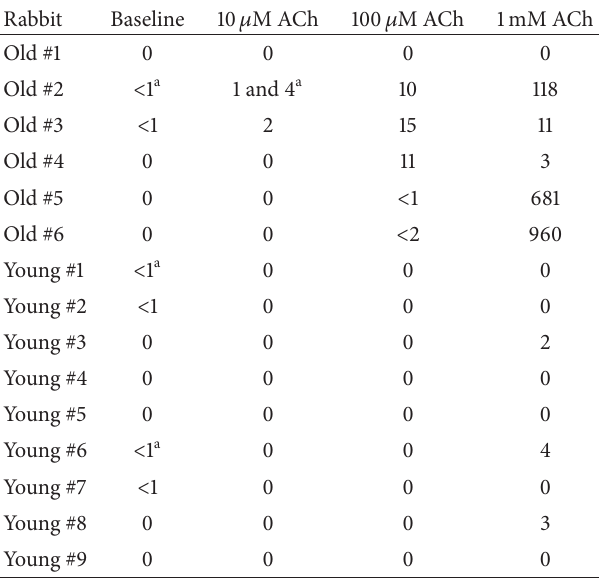
Numbers represent the duration (in seconds) of atrial fibrillation or atrial tachycardia induced. a Atrial